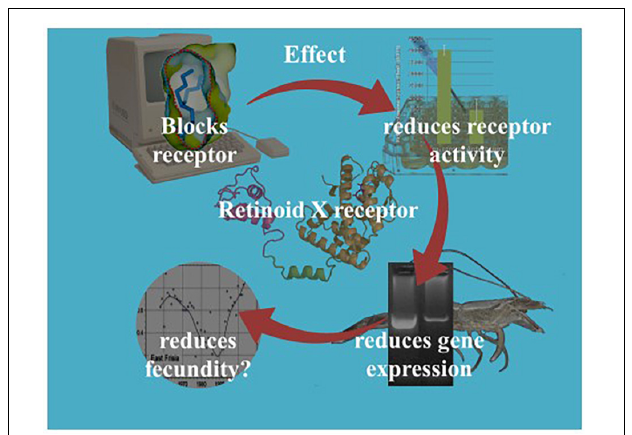
FIGURE 4 | Illustration of the retrospective/diagnostic ecotoxicological research on TBT’s endocrine disrupting role in C. crangon , incorporating in silico , in vitro, and in vivo technologies.